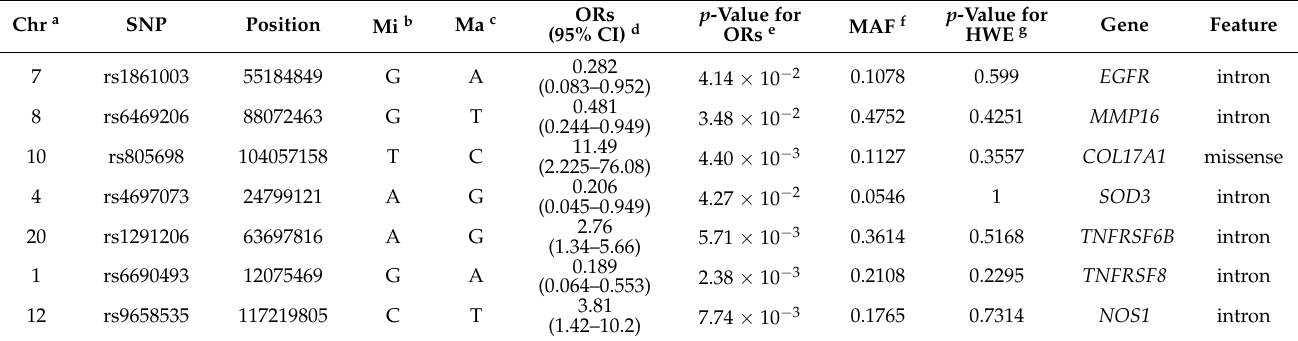
a The position of the single nucleotide polymorphism (SNP) in the chromosome. b Minor allele; c major allele; d odds ratio for each genetic variant to influence wrinkle risk; e p value for odds ratios that have an association with wrinkle risk after adjusting for covariates including age and UV exposure. f minor allele frequency; g Hardy-Weinberg equilibrium. EGFR , epidermal growth factor receptor; MMP16 , matrix metalloproteinase; COL17A1 , collagen type XVII alpha 1 chain; SOD3 , superoxide dismutase 3; TNFRSF , tumor necrosis factor (TNF) receptor superfamily member; NOS1 , nitric oxide